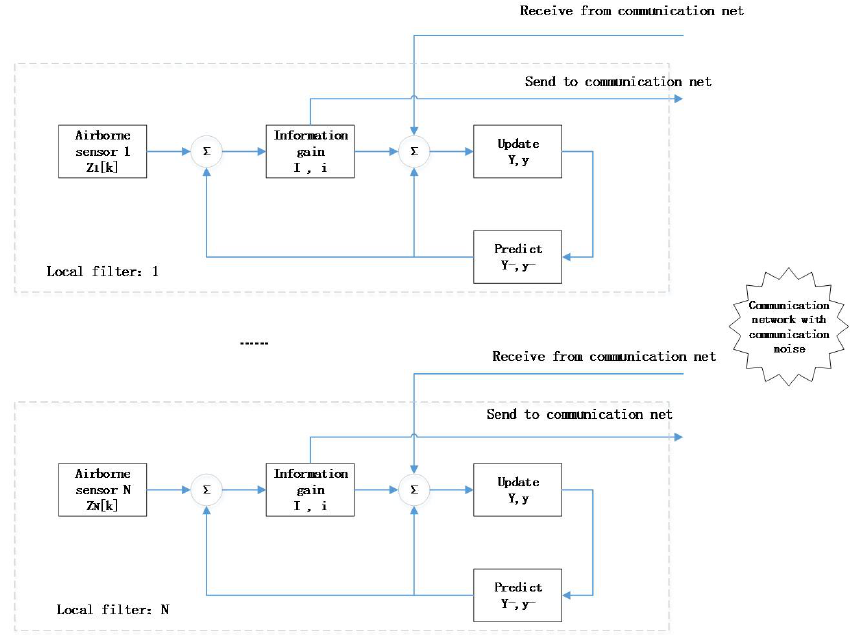
Figure 2. Information fusion structure.